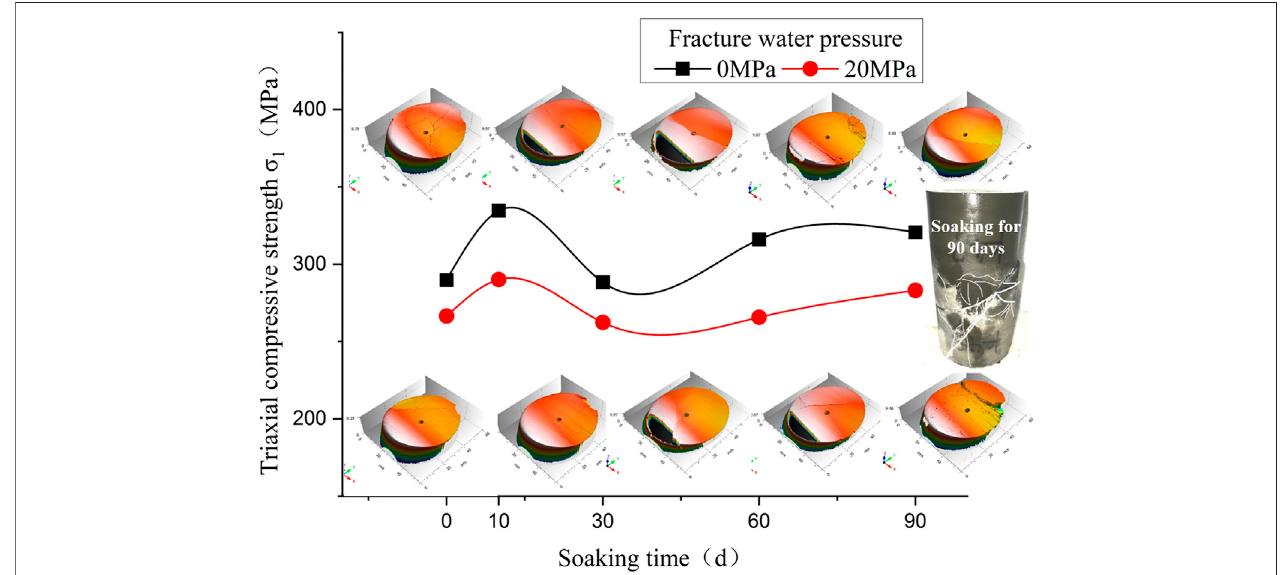
FIGURE 3 | Triaxial compressive strength and joint concave surface change with immersion